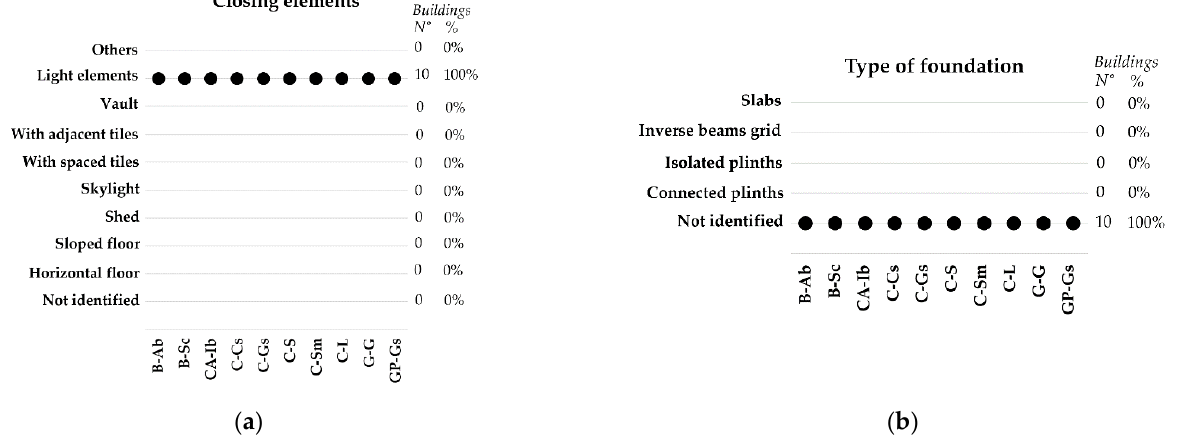
Figure 15. Section 1B CARTIS-Building. ( a ) Closing elements; ( b ) Foundation.